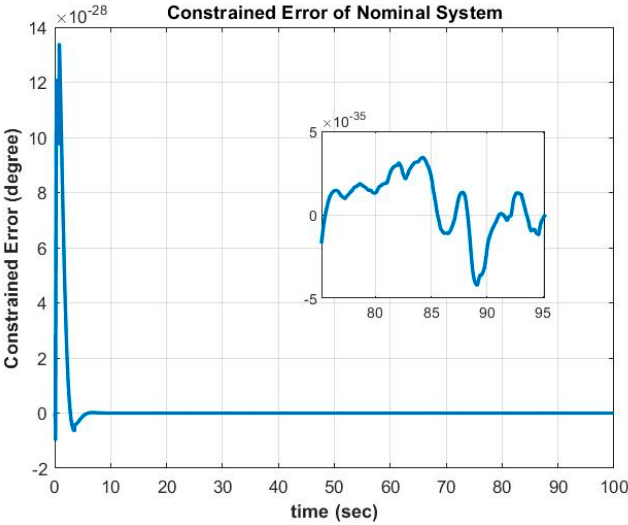
Figure 6. The error in satisfaction of the constraint equation ϕ 1 s = p d + q d sin ϕ tan θ + r d cos ϕ tan θ = 0.